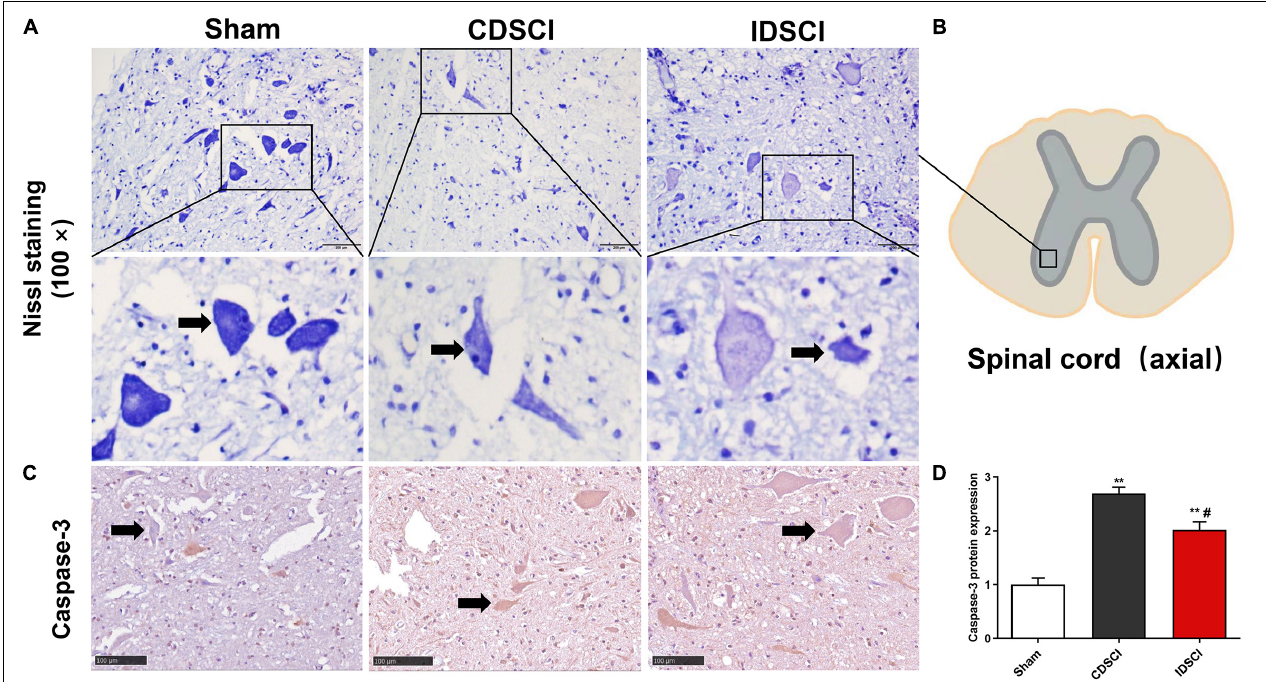
FIGURE 4 | The survival of neurons (black arrows) and apoptosis level in the anterior horn of spinal gray matter tissues after DSCI. (A) Representative images of Nissl staining of neurons in the anterior horn of spinal gray matter tissues in the different groups. (B) The boxed area in the axial spinal cord diagram showed the approximate position of the captured images. (C) The representative immunohistochemical images regarding Caspase-3 of different groups are listed (scale bar = 100 µ m). (D) The mean optical density (MOD = IOD/Area) of the immunohistochemistry-positive sites in the sample sections was determined as the protein expression level ( n = 3). All values are expressed as means ± SD. * P < 0.05, ** P < 0.01, vs. the sham group; # P < 0.05, ## P < 0.01, vs. the CDSCI